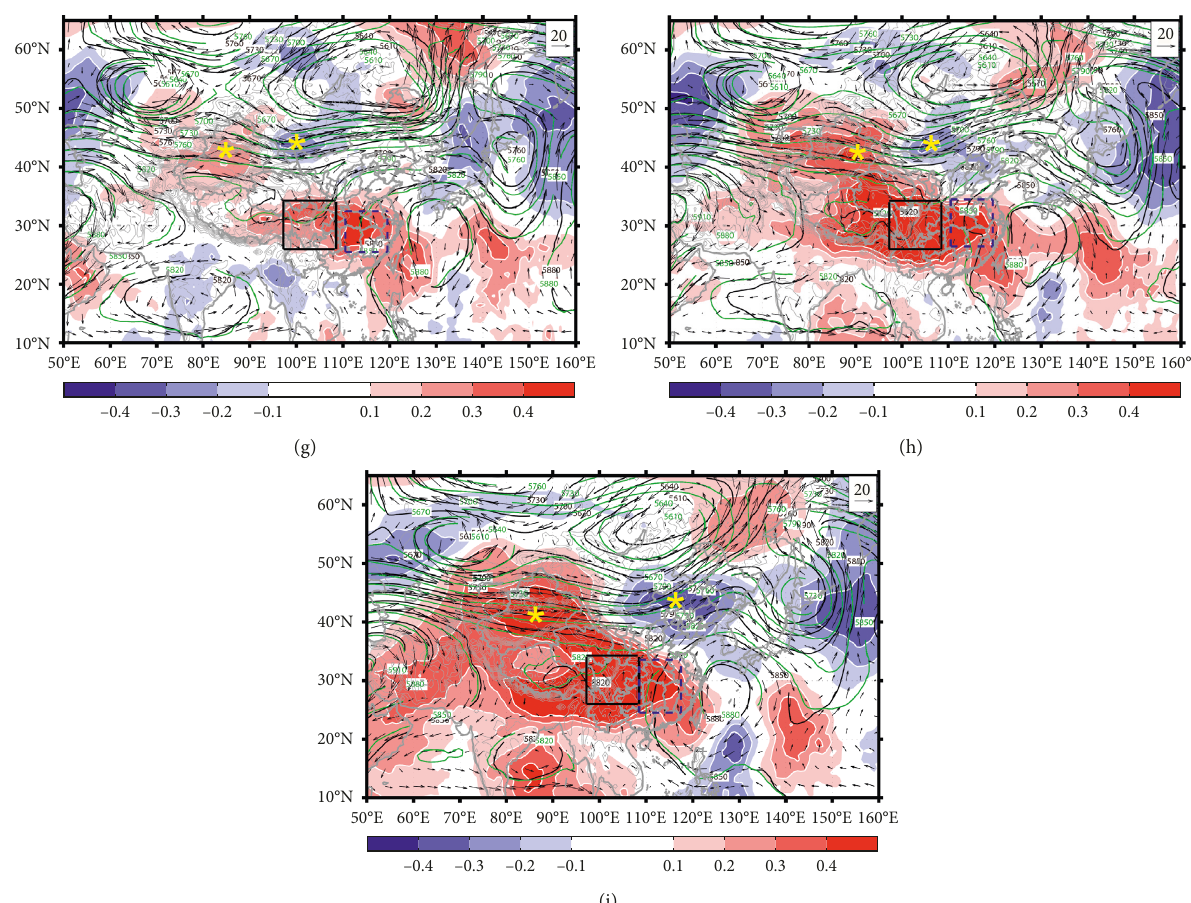
Figure 6: Correlation (color shading) between TPMVI and 500hPa GPH in the 50-member forecast for next 0 to 84 h (12 h interval) in (a–h) and for next 90–108h (4-time average, 1800 UTC 17 July–1200 UTC 18 July) in (i) initialized at 0000 UTC 14 July 2013. The black contours and black vectors are the ensemble-mean of the 500hPa GPHs (unit: gpm) and winds (unit: m/s) of 6 stronger members, and the green contour is the ensemble-mean of the 500hPa GPHs (unit: gpm) of 6 weaker members. The asterisk shows the significant location of the correlation according to the synoptic systems coherent rules. The blue boxes in Figures 6(a)–6(i) show the area with correlations coefficient roughly beyond the 95% confidence level near WPSH and the black boxes indicate the TPMV over the SCB,